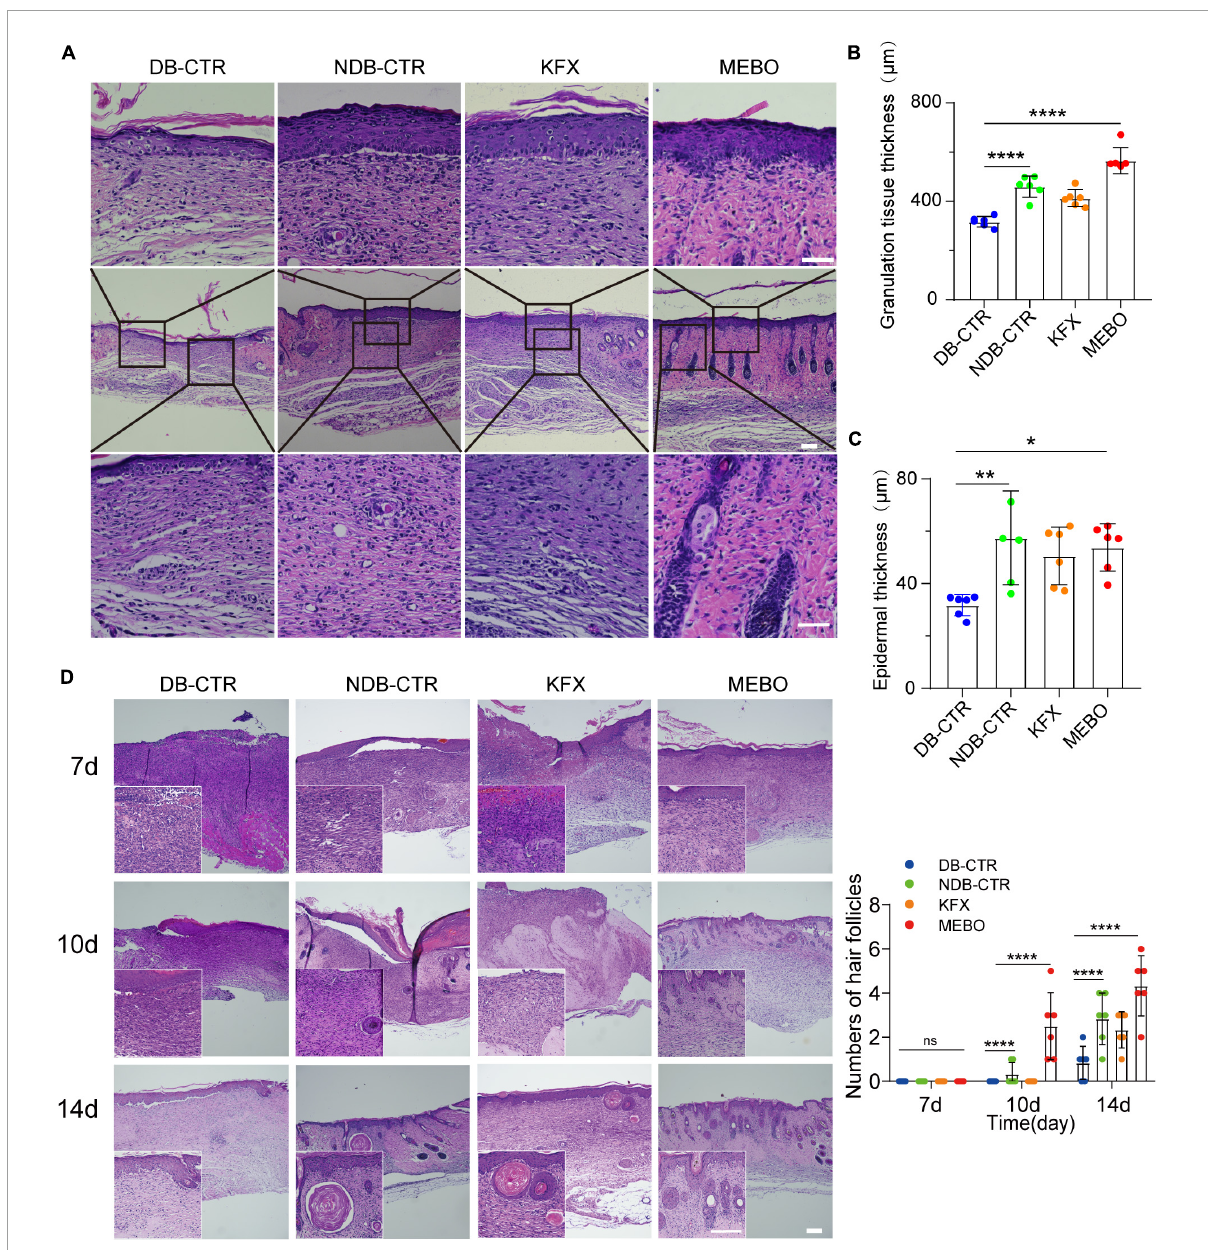
FIGURE3 MEBO accelerated the formation of granulation tissue and mature epithelial structure in diabetic wounds. (A) The representative images of H&E staining of regenerated skin tissue of mice in each group on the 14th day after surgery. The scale is 50 µ m. (B) The granulation tissue thickness of regenerated skin in each group was quantitatively analyzed by ImageJ software. (C) The epidermis thickness of regenerated skin in each group was quantitatively analyzed by ImageJ software. (D) High-magnification images showing the formation process of hair follicles in each group at days 7, 10, and 14. The scale is 500 µ m (10X) and 50 µ m (40X). The number of hair follicles in each group was calculated. At least 6 independent sections were chosen at each time for each group. All Data are shown as mean ± SD, ns P > 0.05, * P < 0.05, ** P < 0.01, *** P < 0.001, **** P <